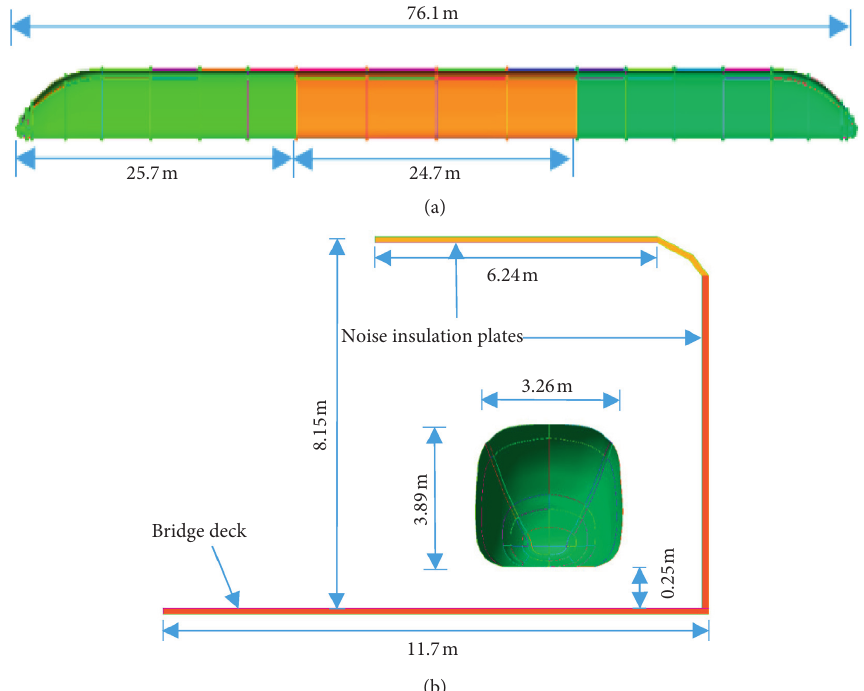
Figure 3: CFD Model of SESB: (a) simplified high-speed train model; (b) dimensions and cross section of train and noise barrier.